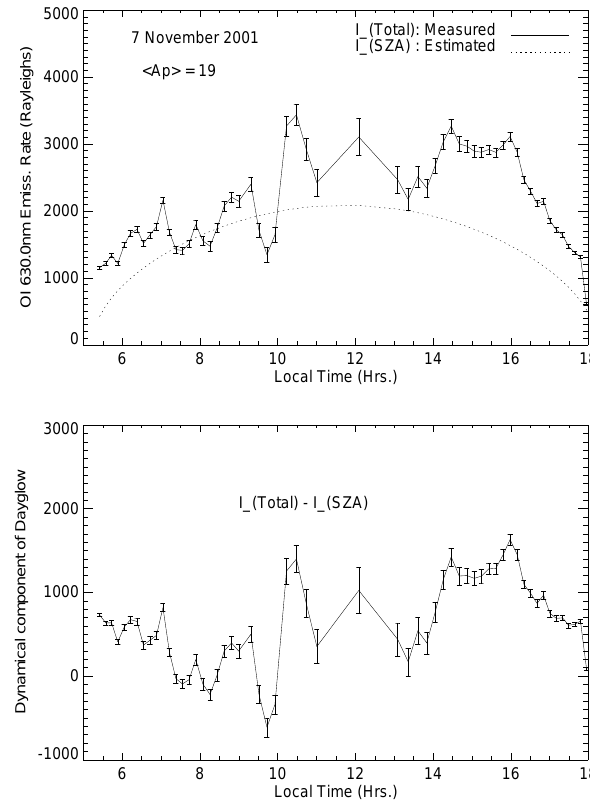
Fig. 4. Same as in Fig. 2 but for 7 November 2001. Notice the peri- odicities of small-amplitude oscillations, which seem to increase in time periods from around 30min in the morning to around 100min in the evening. Whether such a behavior in wave activity is an af- tereffect of severe magnetic storms is currently under investigation, as such an increase in the wave periodicities are not seen on the two previous